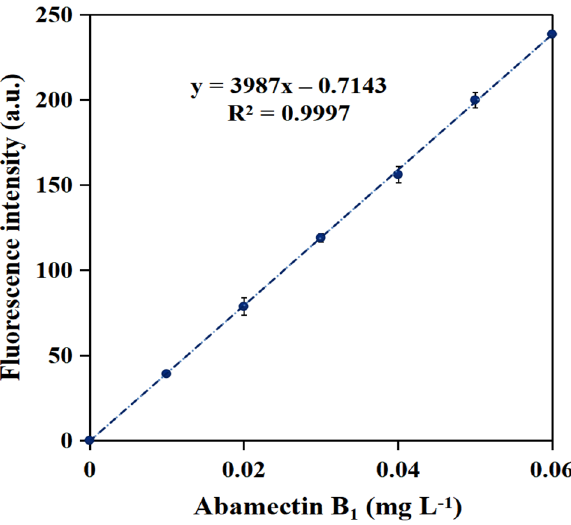
Figure 6. Plot of fluorescence intensity differences with 0.00–0.06 mg L −1 abamectin B 1 . Excitation wavelength: 360 nm, Emission wavelength: 420 nm.